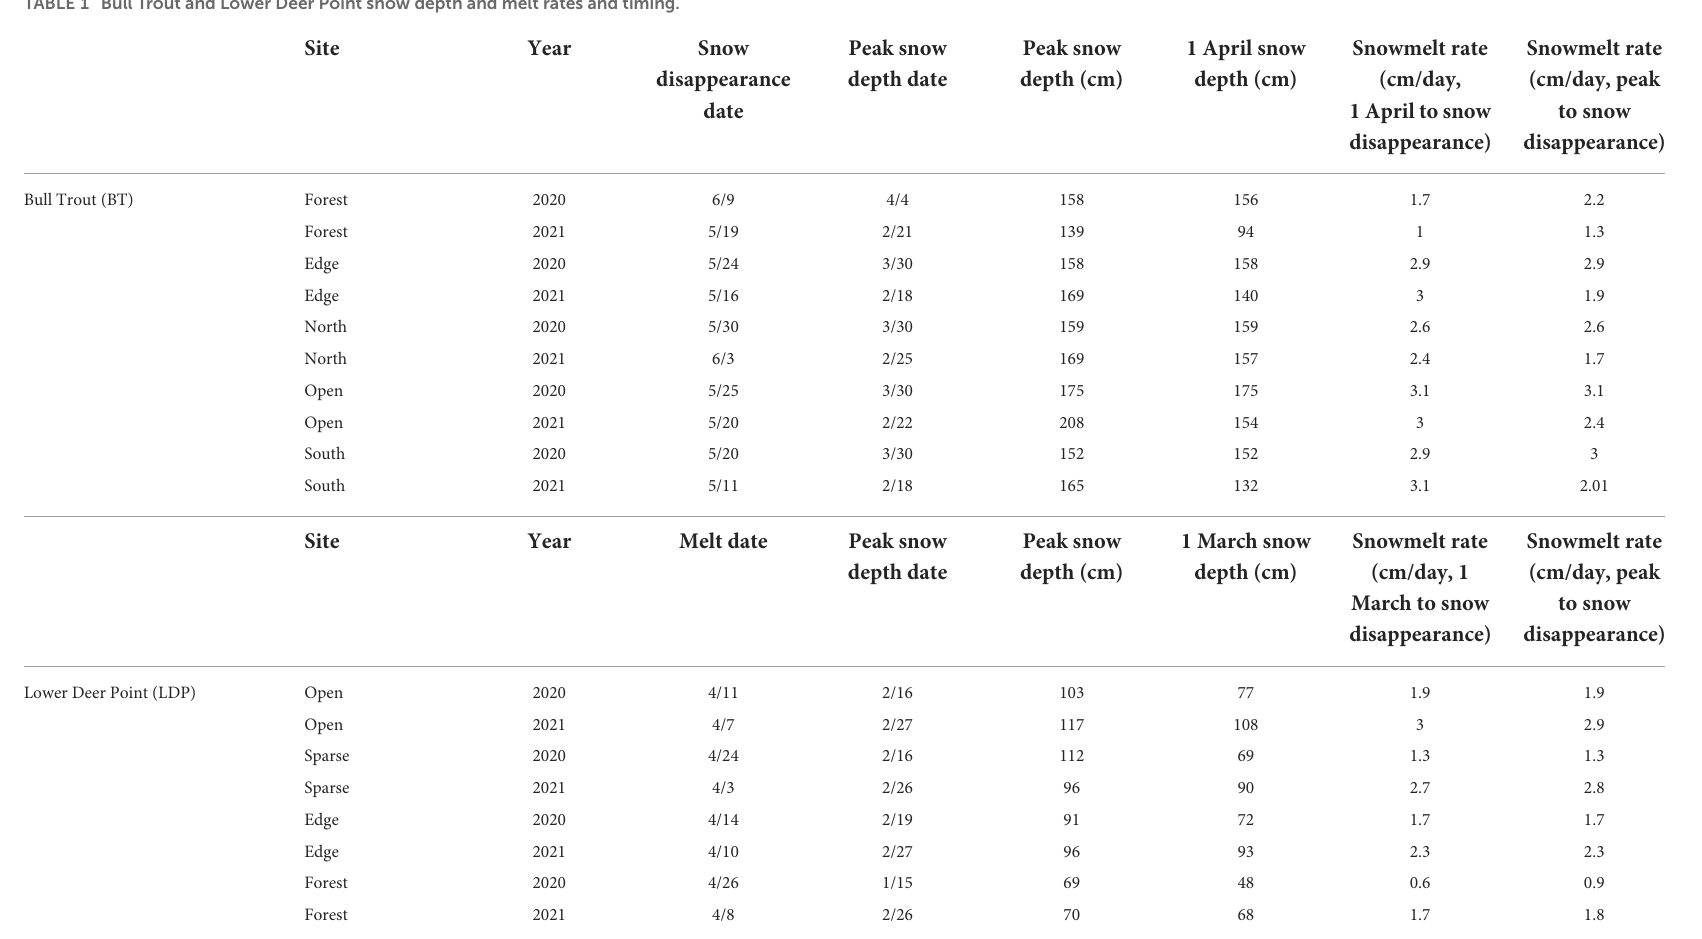
TABLE 1 Bull Trout and Lower Deer Point snow depth and melt rates and